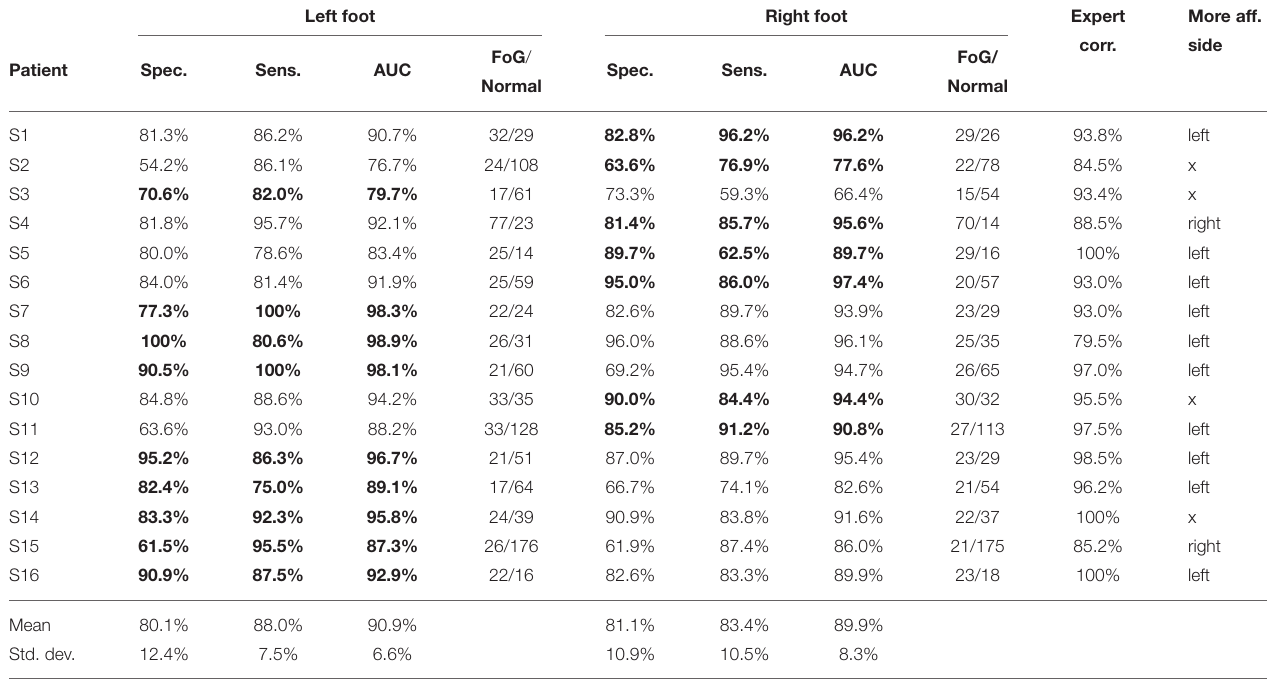
TABLE 6 | Results of the SVM classifier C 0 for each patient trained on all 10 features of the actual motion phase (SVM_10). Left foot Right foot Expert